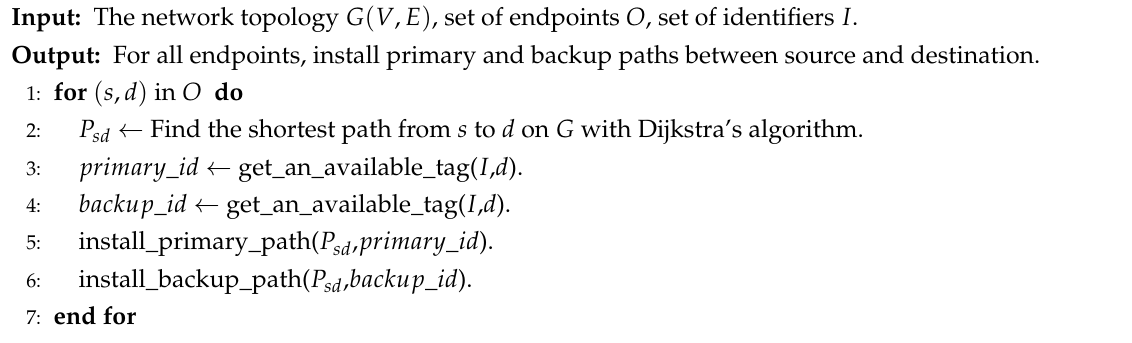
Algorithm 1 The algorithm of LONG for the protection